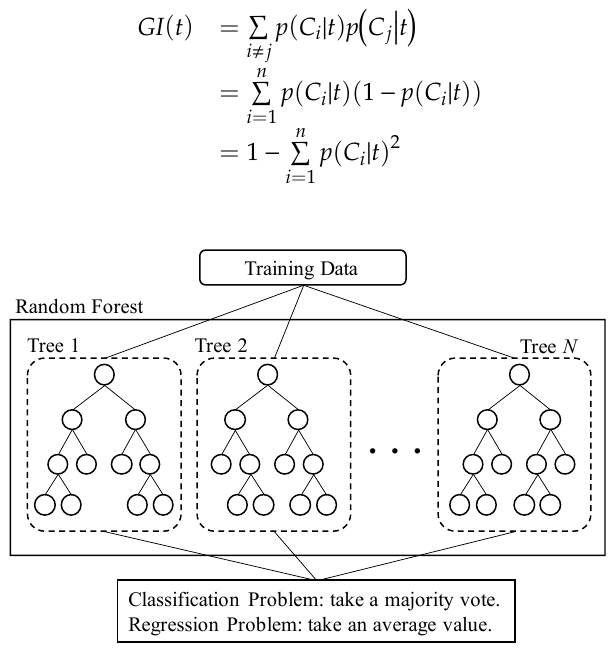
Figure 14. Random Forest.